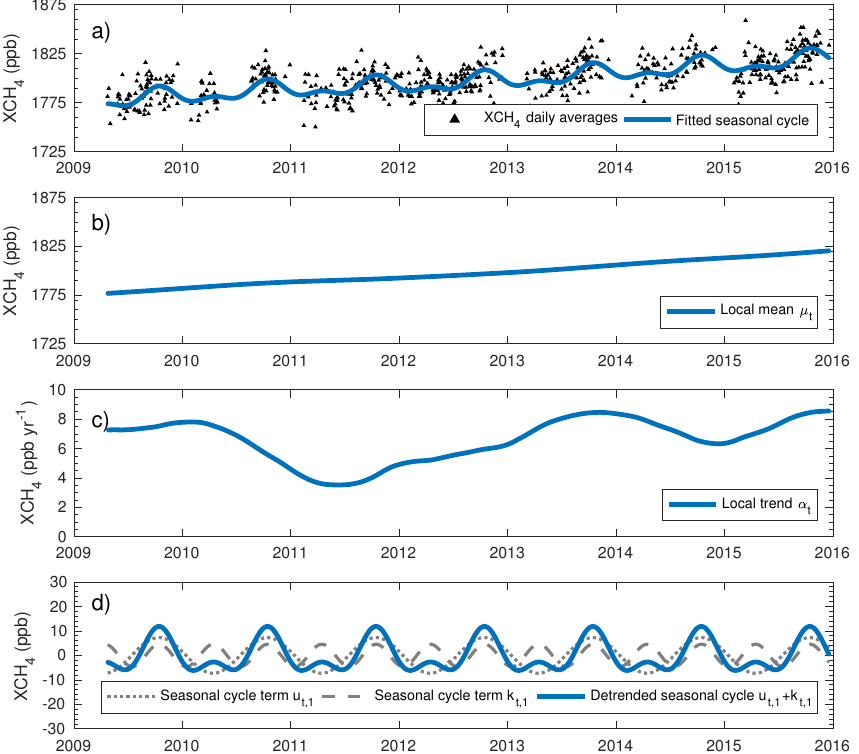
Figure A3. Example of DLM state vector x t components (Equation (A3)) for GOSAT NIES retrieval at Park Falls TCCON